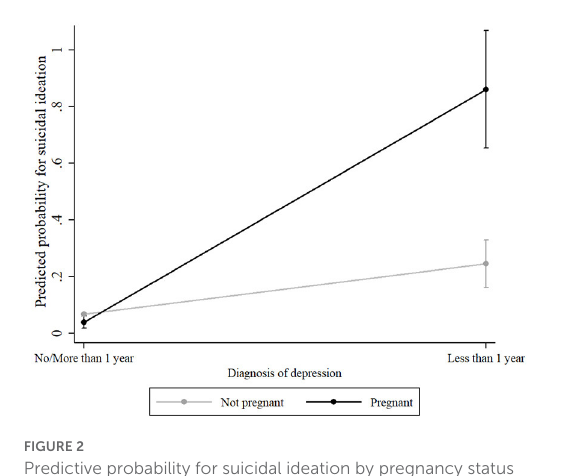
FIGURE2 Predictive probability for suicidal ideation by pregnancy status and diagnosis of depression. Figure 2 was drawn by estimating the predictive probability of the interaction effect of pregnancy status x diagnosis of depression and plotting them with 95% CI by predictive margins and marginsplot of